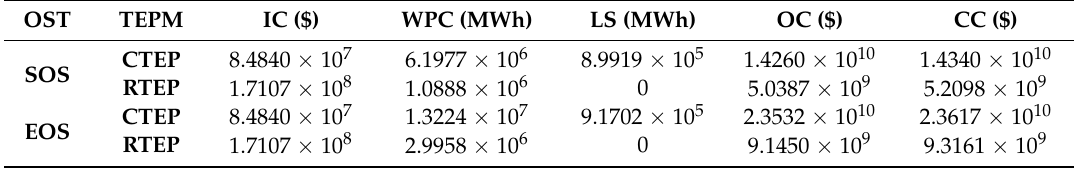
Table 6. Results of the proposed RTEM method and the CTEP method for the IEEE RTS-79 system.